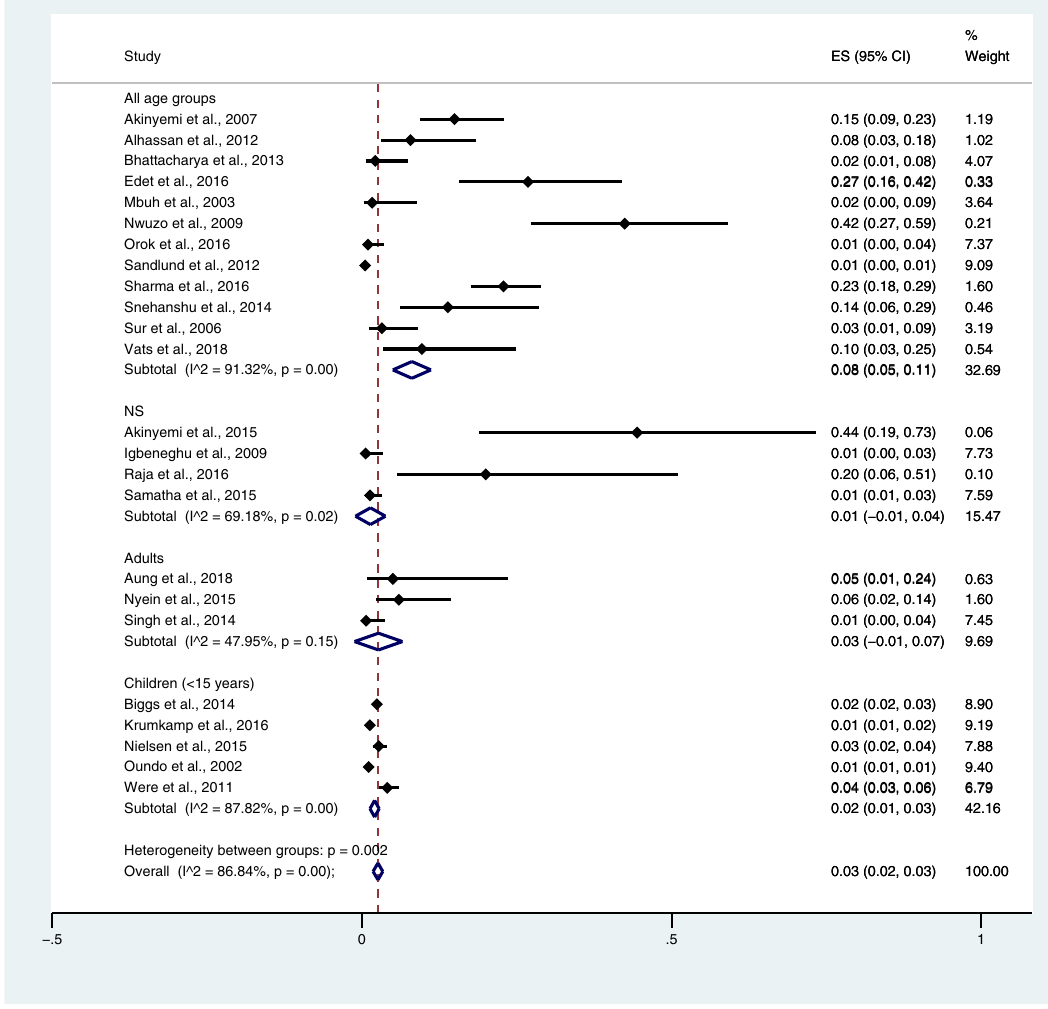
Figure 15. Prevalence of typhoidal/NTS infection among patients with malaria using blood cultures for the identification of Salmonella spp. infection stratified by age groups. ES proportion estimate (multiply 100 units for interpreted as prevalence estimate), CI confidence interval, NS not